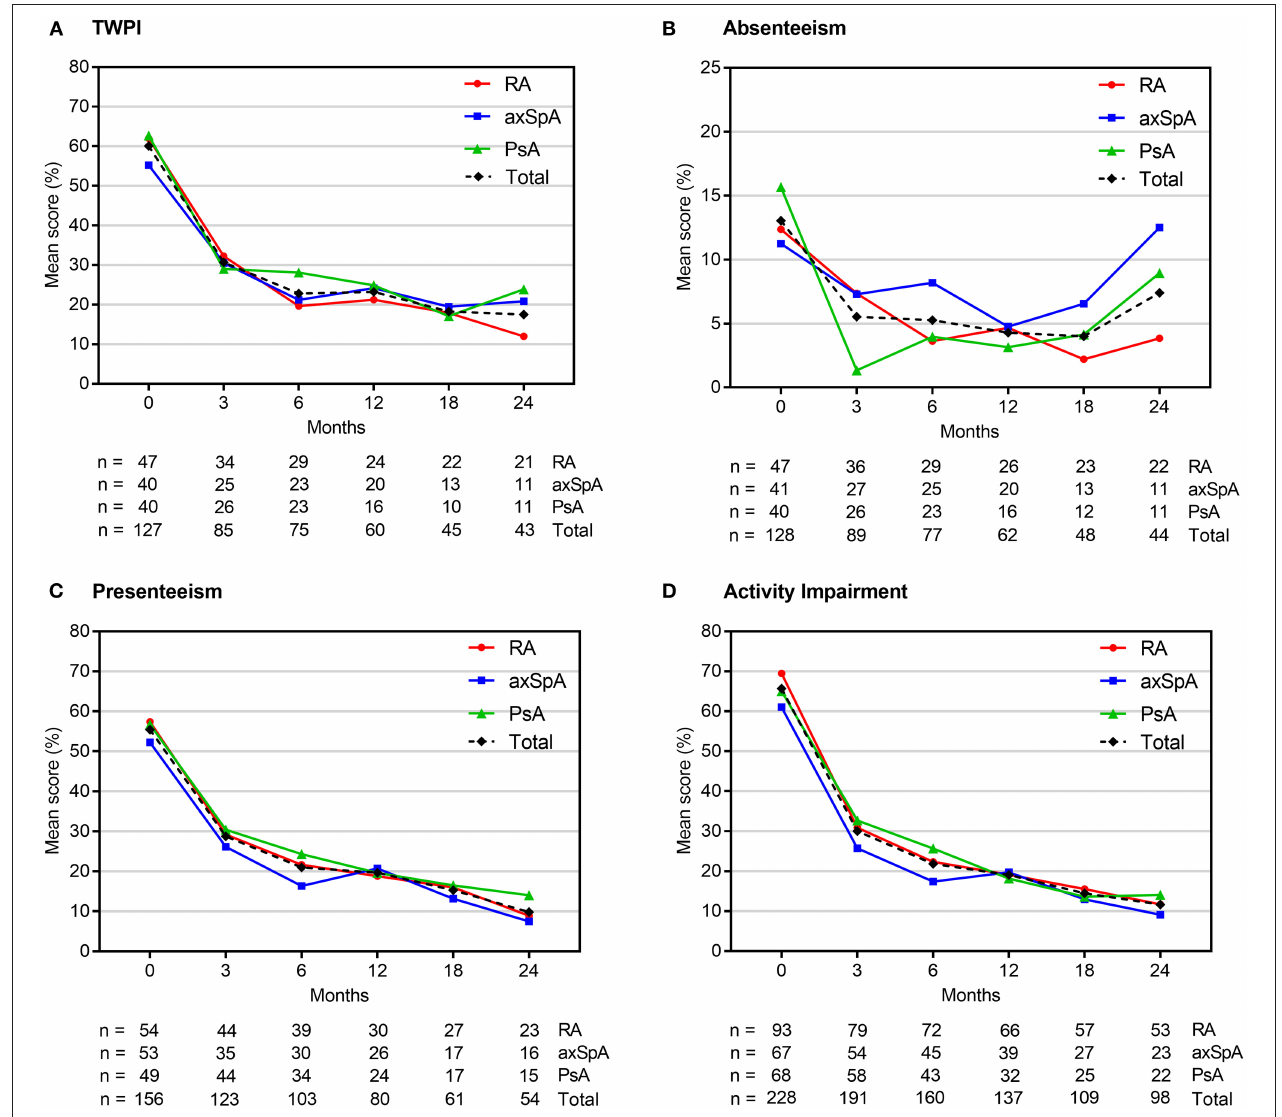
FIGURE 2 | Mean WPAI scores at each study visit. Scores are expressed as percentages (from 0 to 100%), with higher values indicating a greater impairment. axSpA, axial spondyloarthritis; PsA, psoriatic arthritis; RA, rheumatoid arthritis; TWPI, total work productivity impairment; WPAI, work productivity and daily activity